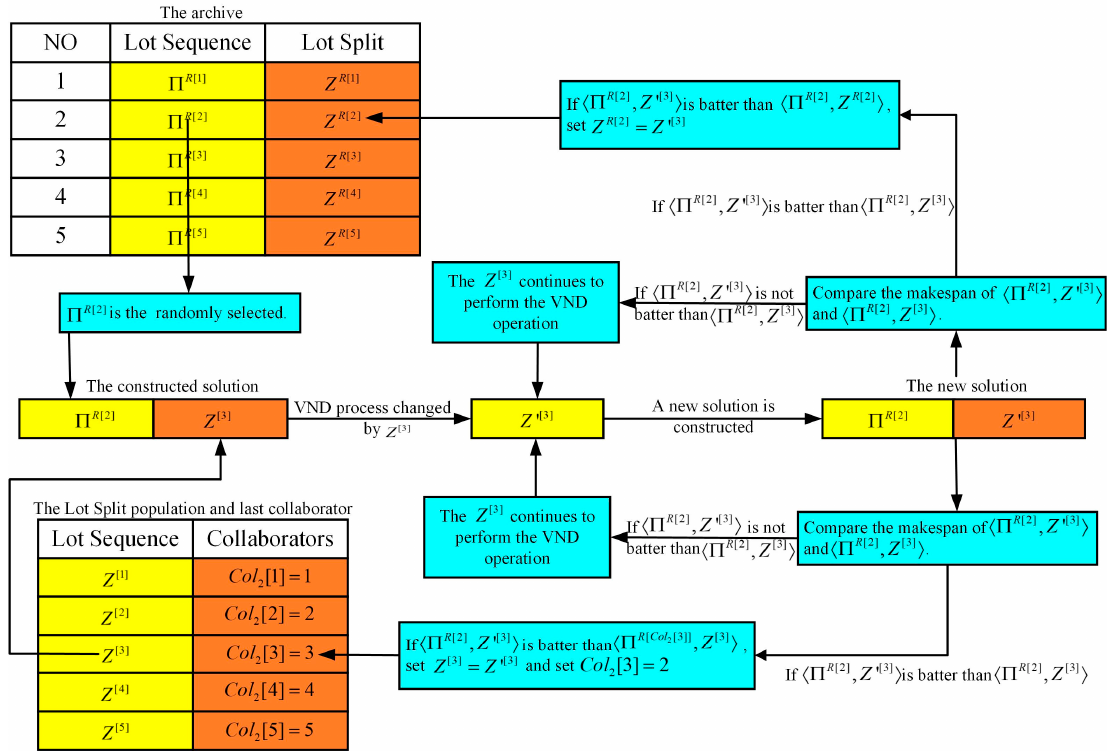
Figure 4. Evolution process of the lot split population.